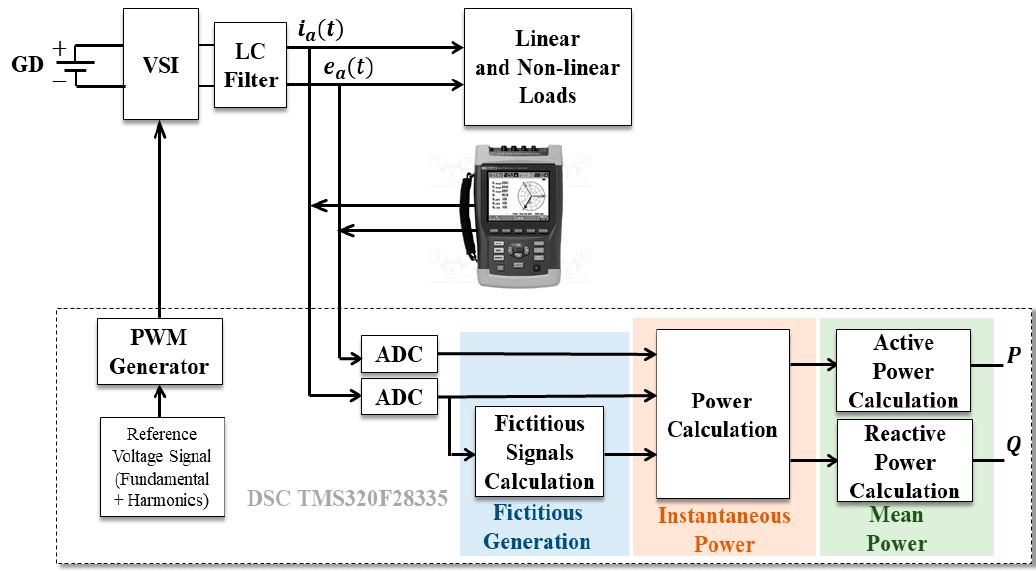
Figure 1. Power measurement system.